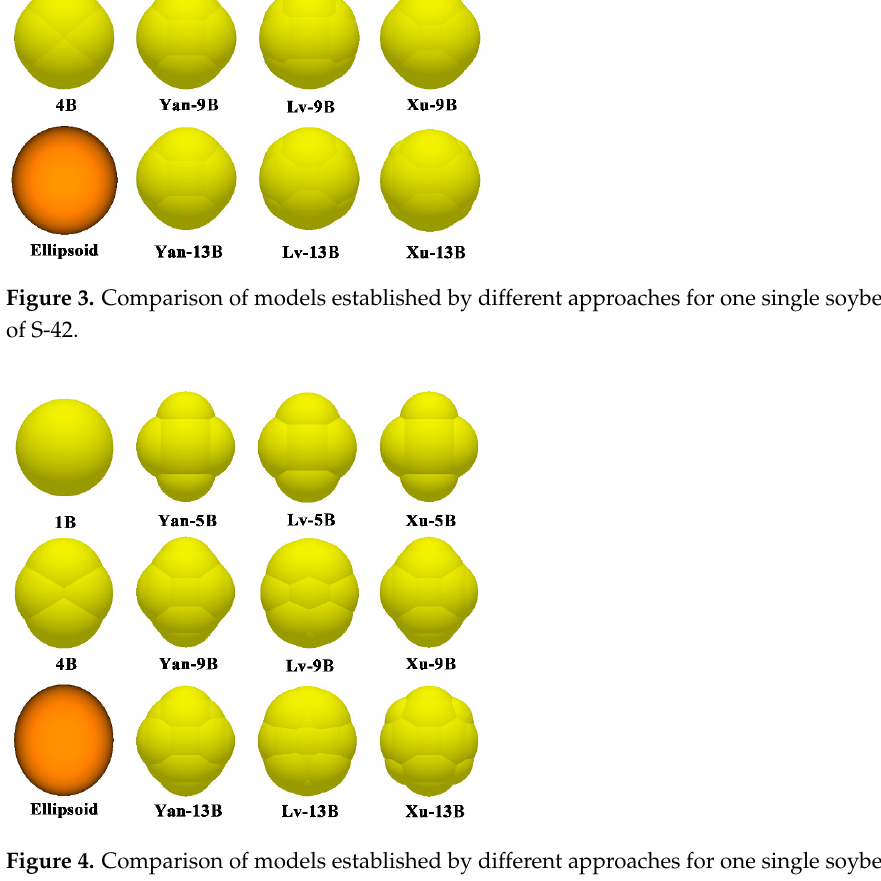
Figure 5. Comparison of models established by different approaches for one single soybean parti- cle of Z-39.